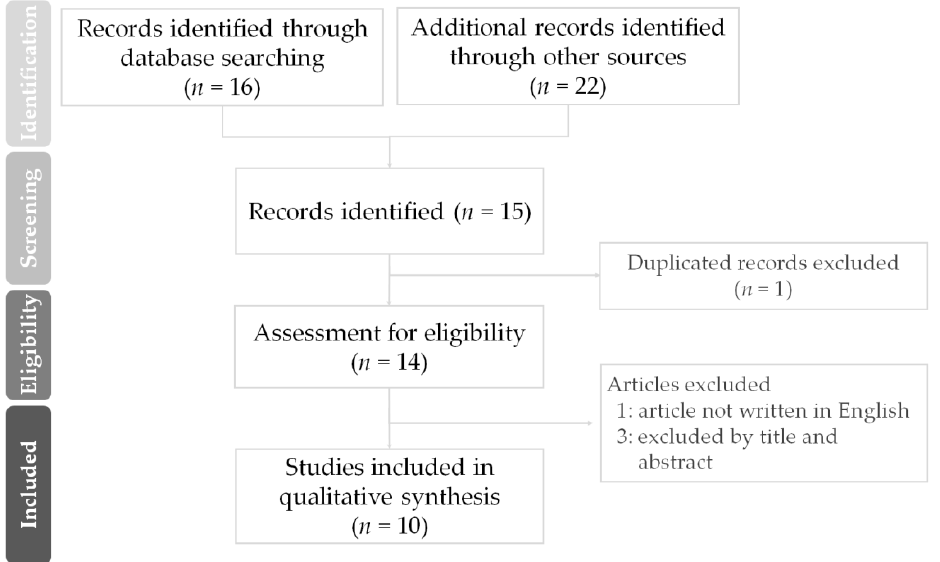
Figure 1. The flow diagram of PRISMA showed the processing of article screening in this study.